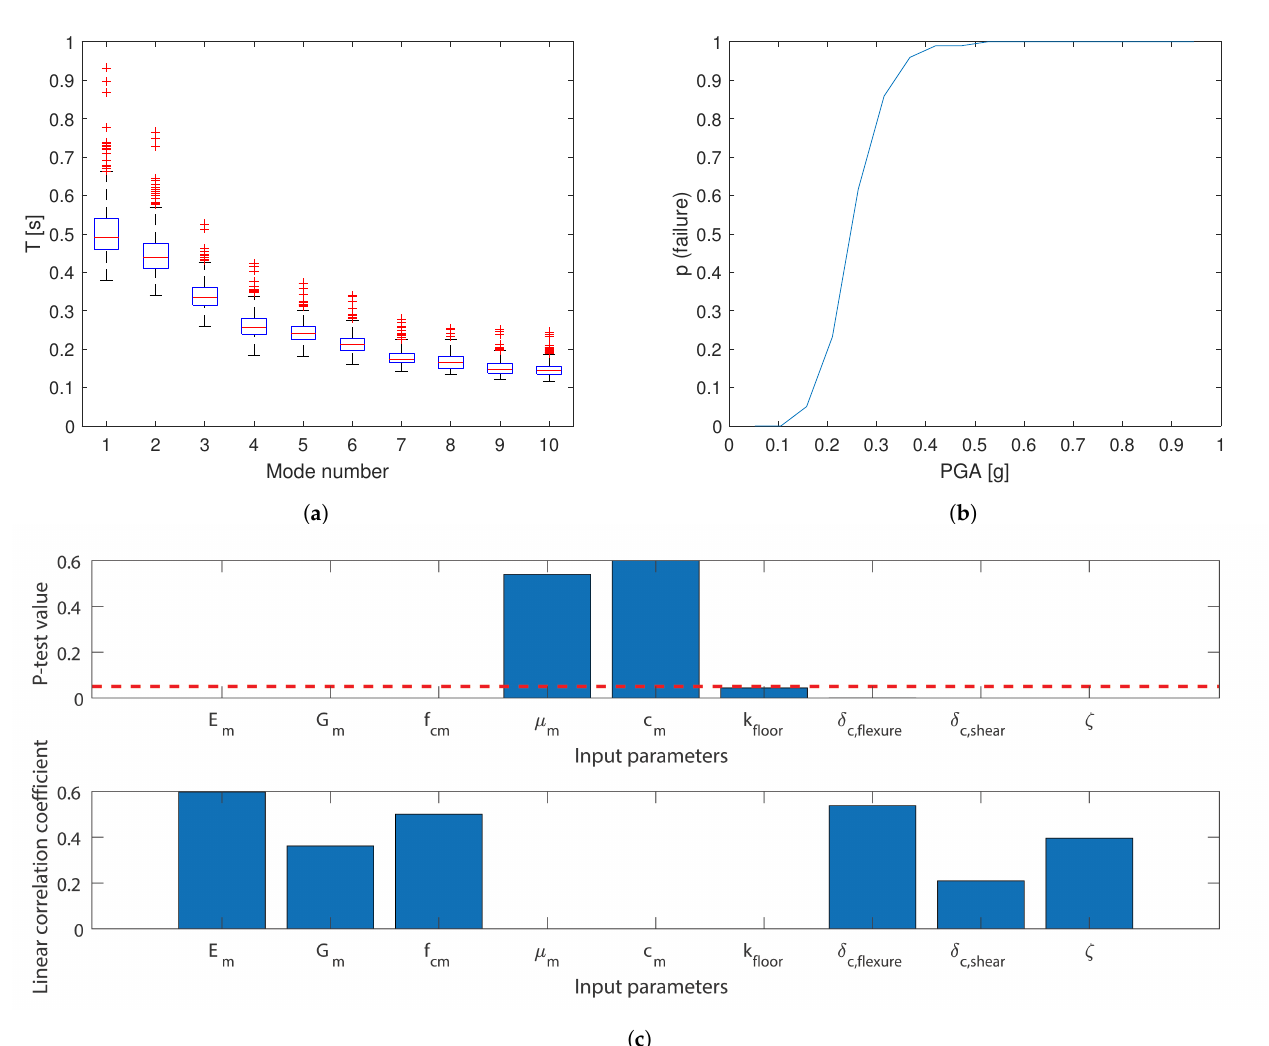
Figure 22. Lausanne Malley model with out-of-plane disabled and rigid connections: ( a ) Distribution of modal periods. ( b ) Fragility curve. ( c ) Correlations between PGA at failure and input